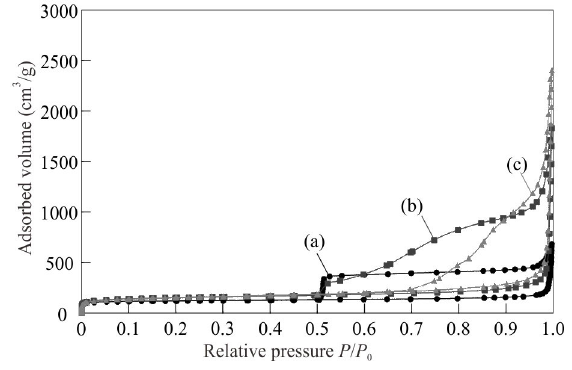
Fig. 4 N 2 sorption isotherms of the hollow silica–alumina composite spheres prepared using (a) 40, (b) 80, and (c) 120 g of the PS